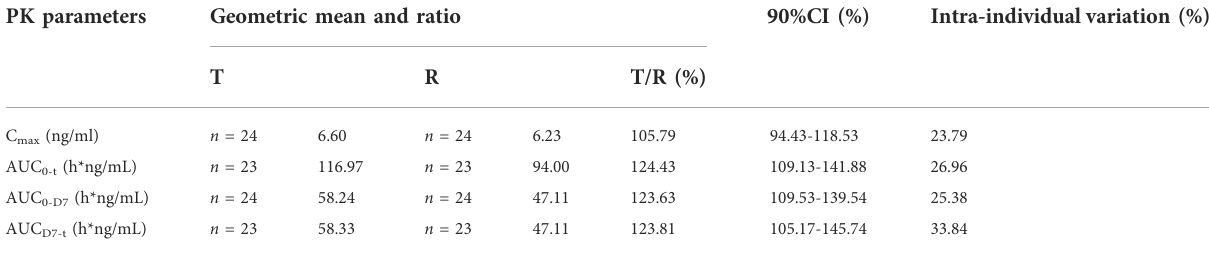
TABLE 2 Pharmacokinetic parameters of leuprolide: Geometric mean ratio and 90% con fi dence interval. PK parameters